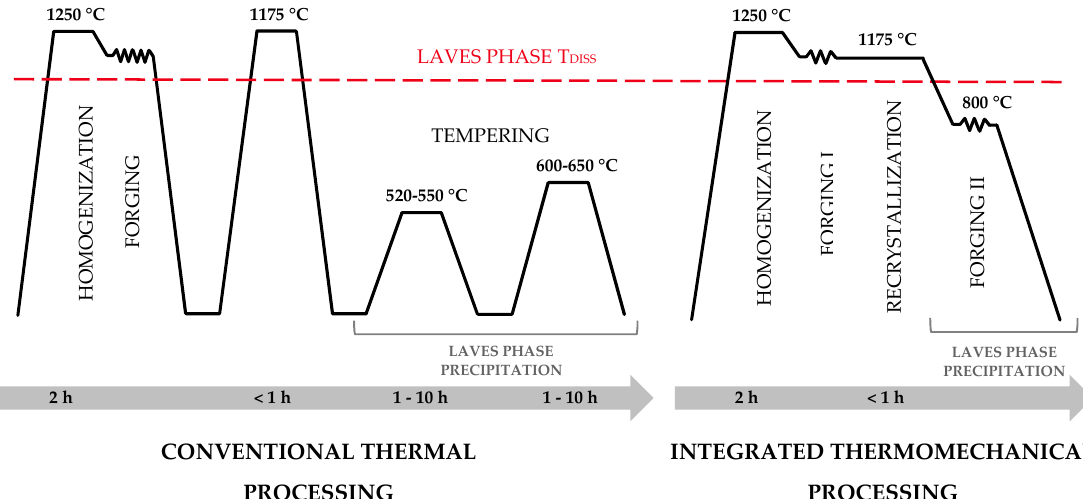
Figure 1. Conventional thermal versus integrated thermomechanical process routes with indicated Laves phase dissolution temperature T DISS .